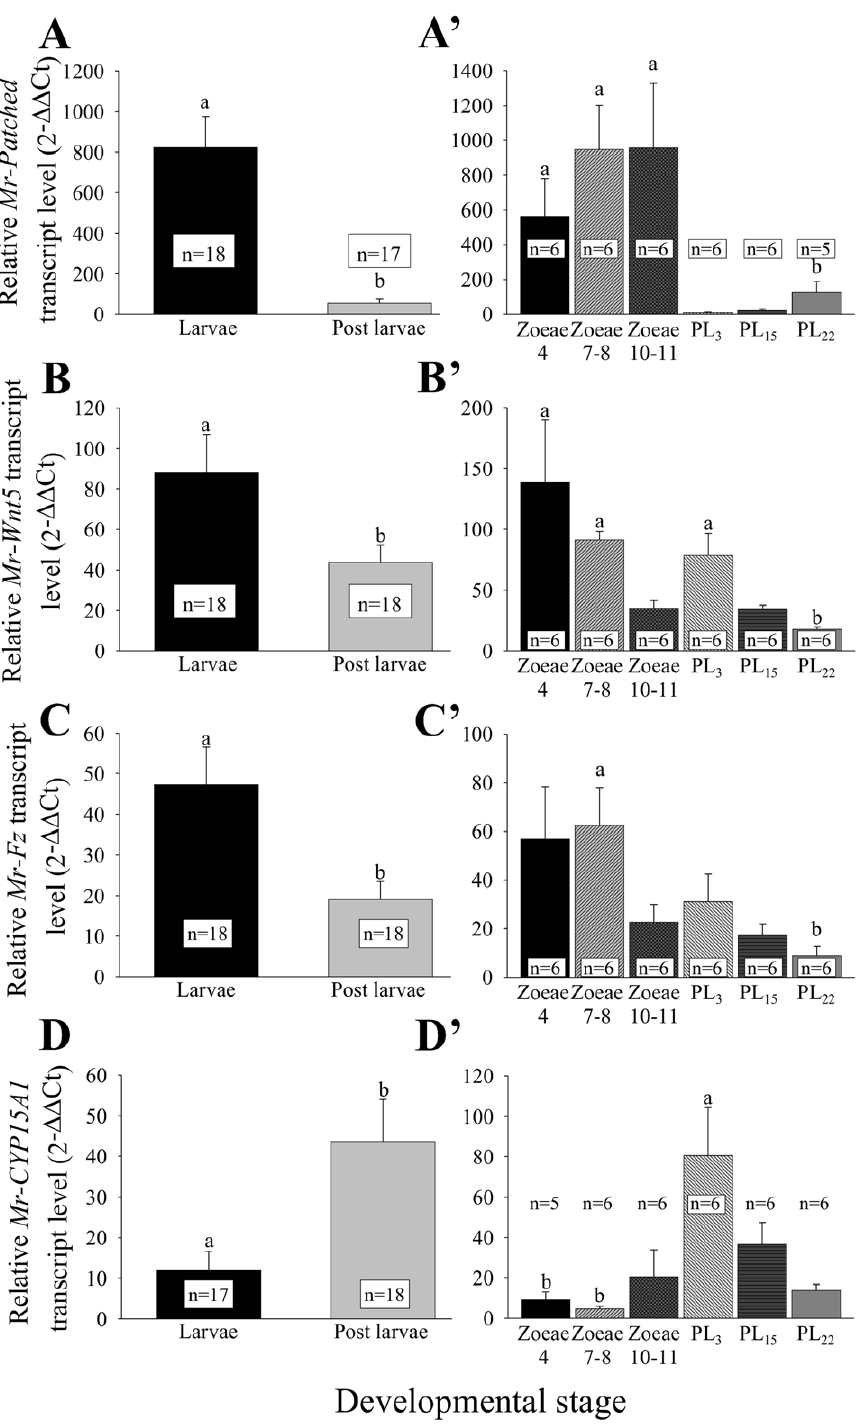
Figure 4. Relative transcript levels of key metamorphosis-related genes. Relative transcript levels of Mr-Patched , Mr-Wnt5 , Mr-Fz and Mr- CYP15A1 were quantified via real-time RT-PCR in larvae and PLs (n=18 in each group). Different letters represent significant differences, while error bars represent SEM. Comparison of relative Mr-Patched ( A ), Mr-Wnt5 ( B ) and Mr-Fz ( C ) transcript levels in larvae and PLs reveals a highly significant difference (Mann-Whitney U test, P -value , 0.01), supporting the ratio of , 20 ( Mr-Patched ) and , 2 ( Mr-Wnt5 and Mr-Fz ) in favor of the larval group compared with PLs, as calculated by the RPM ratio obtained with the transcriptome. Comparison of relative Mr-CYP15A1 ( D ) transcript levels in larvae and PLs also reveals a highly significant difference (Mann-Whitney U test, P -value , 0.01), supporting the higher expression levels expected in PLs, as calculated by the RPM ratio obtained with the transcriptome. However, when dividing the larval and PL groups into defined stages (Zoea 4, 7–8, 10– 11, PL 3, 15, 22 ), the overall trend is more complex, with significantly higher Mr-Patched transcript levels seen in Zoea 4, and 7–8, as compared with PL 15 and PL 22 and also in Zoea 10–11, as compared with PL 22 ( A’ ; Kruskal-Wallis test: H (df=5, N=36) =24.06317, P -value , 0.05), significantly higher Mr- Wnt5 transcript levels seen in Zoea 4, 7–8 and PL 3 , as compared with PL 22 ( B’ ; Kruskal-Wallis test: H (df=5, N=36) =28.50751, P -value , 0.01),